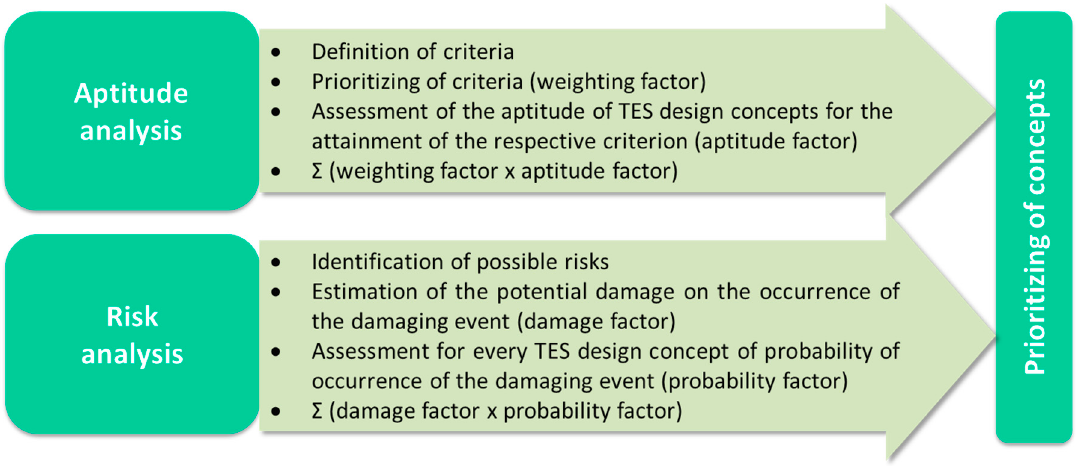
Figure 5. Quality function deployment (QFD)- and failure mode and effect analysis (FMEA)-based analysis approach. Table 4. Criteria for aptitude